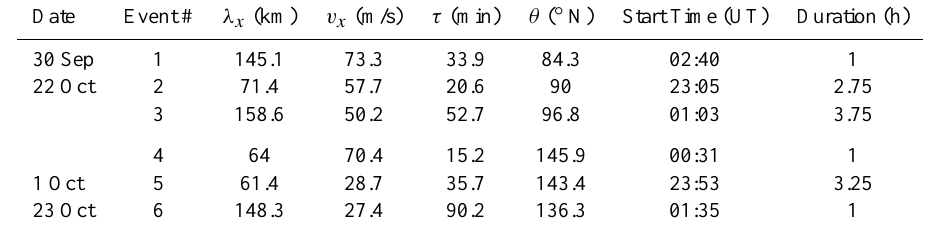
Table 1. Summary of medium-scale waves observed over Brasilia. The estimated uncertainties are ± 10% for the wave measurements.